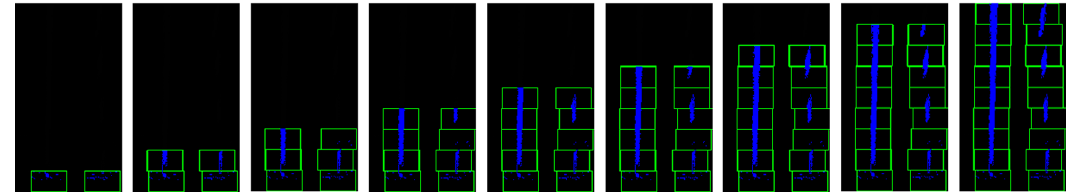
Figure 6. Detecting potential lane markers ’ location based on histogram peak.